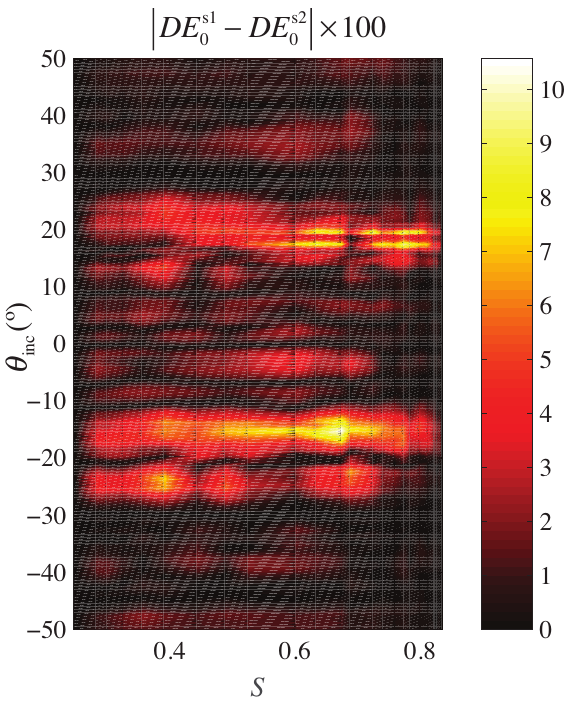
Figure 7. Error between two samples of Grating #1. The color map shows the modulus of the error of the diffraction efficiency (zeroth-order) between samples expressed in